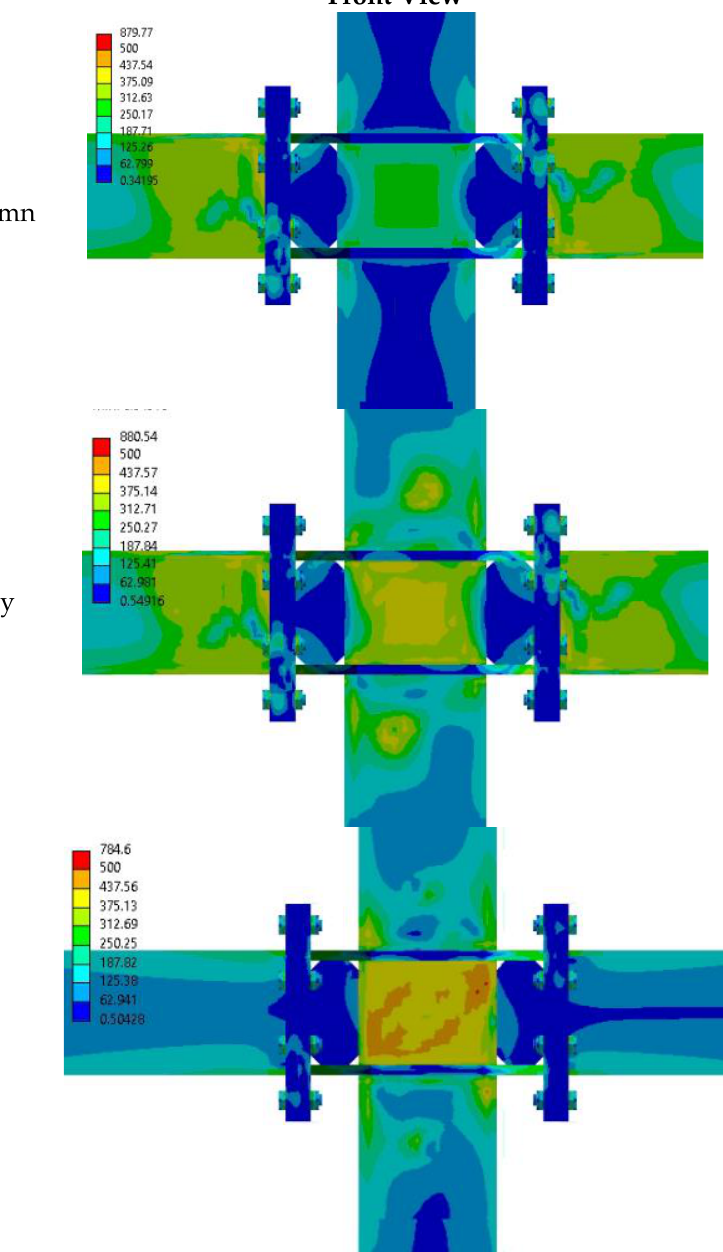
Figure 11. Stress distribution in the 2BI models (Units: MPa).